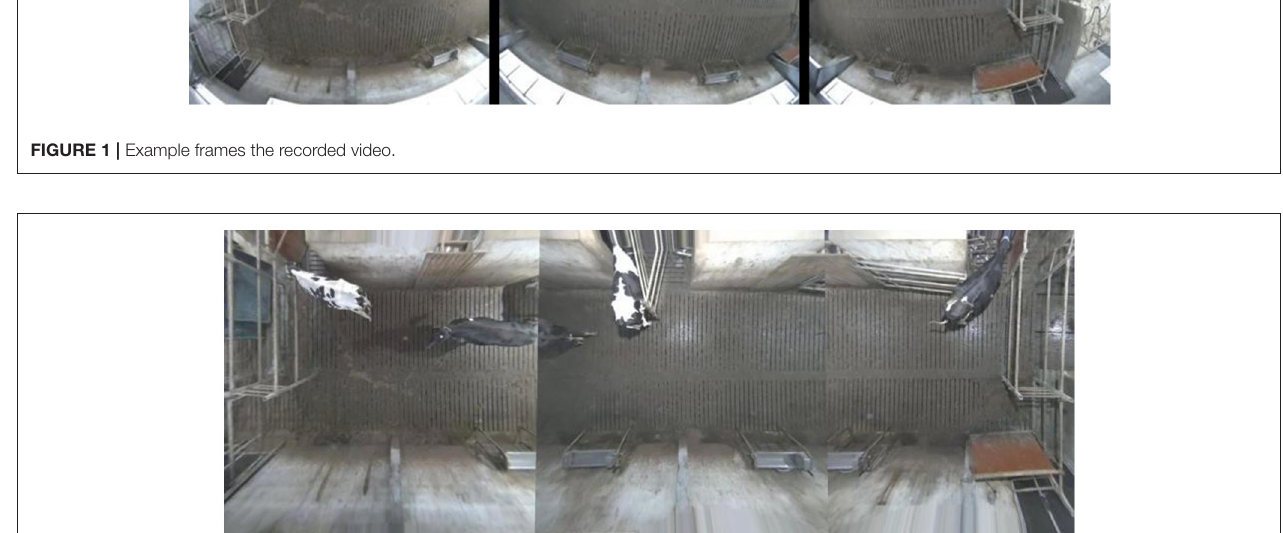
FIGURE 2 | The frames from Figure 1 projected onto the cow shoulder plane and stitched together.